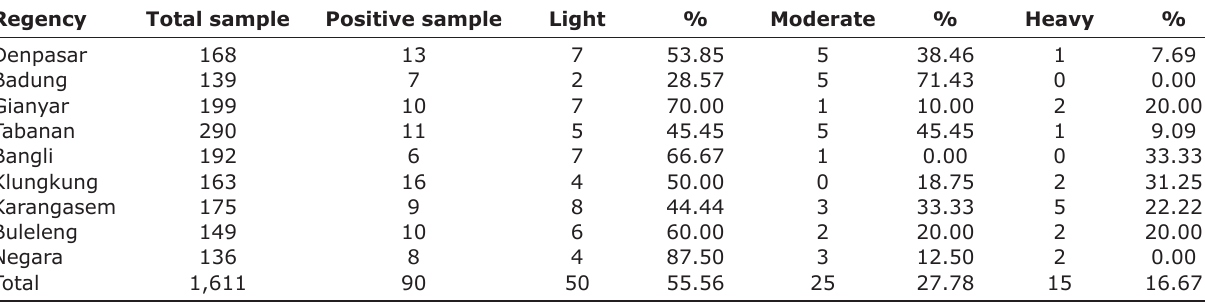
Table-4: The intensity of Ascaris spp . infection in free-roam dogs and its distribution in Bali Province.